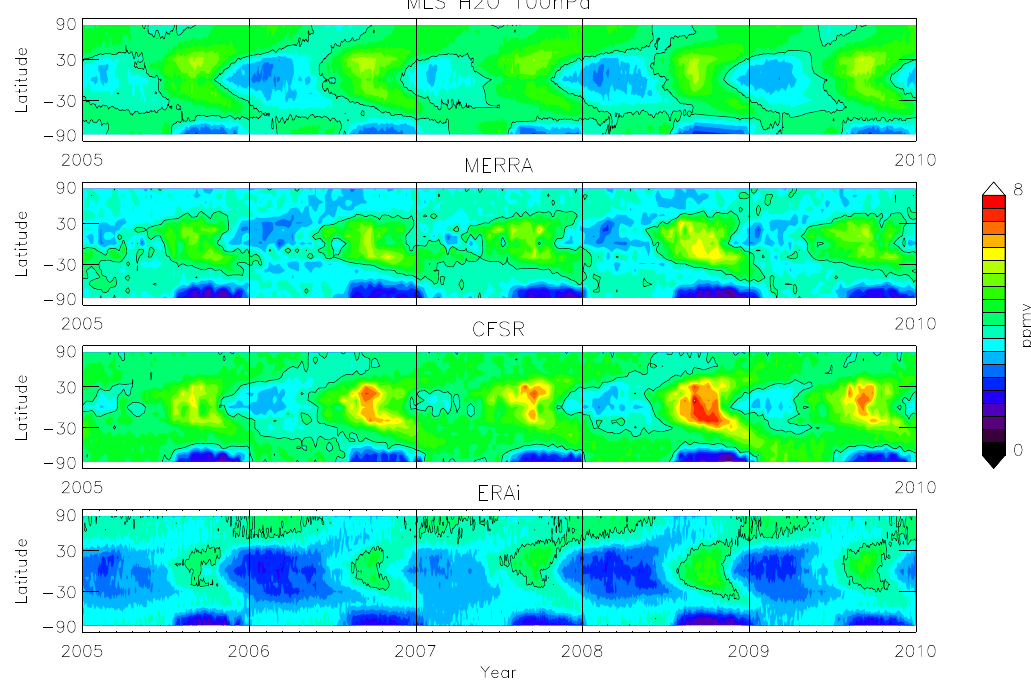
Fig. 9. Times series of 100hPa water vapor for the three reanalyses compared to MLS as in Fig. 4.